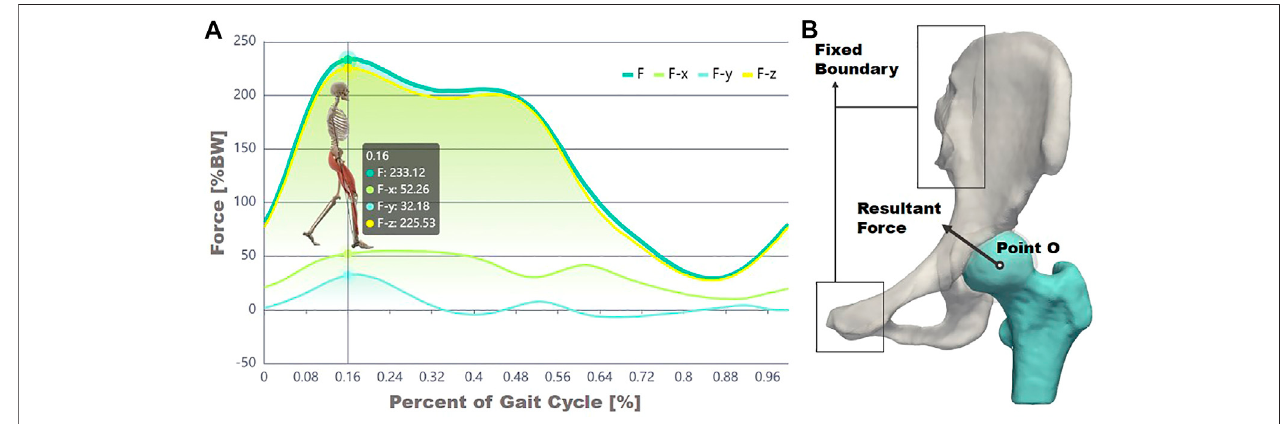
FIGURE 3 | Experimental data of force decomposition over a gait cycle (A) and the illustration of forces and constraint boundary conditions (B) .